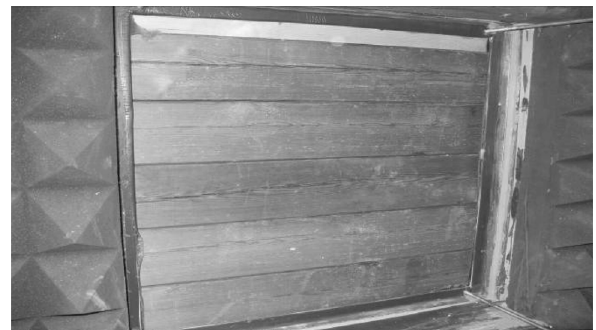
Fig. 4. View of an element of the log wall, 15 cm wide, assem- bled in the noise suppression chamber